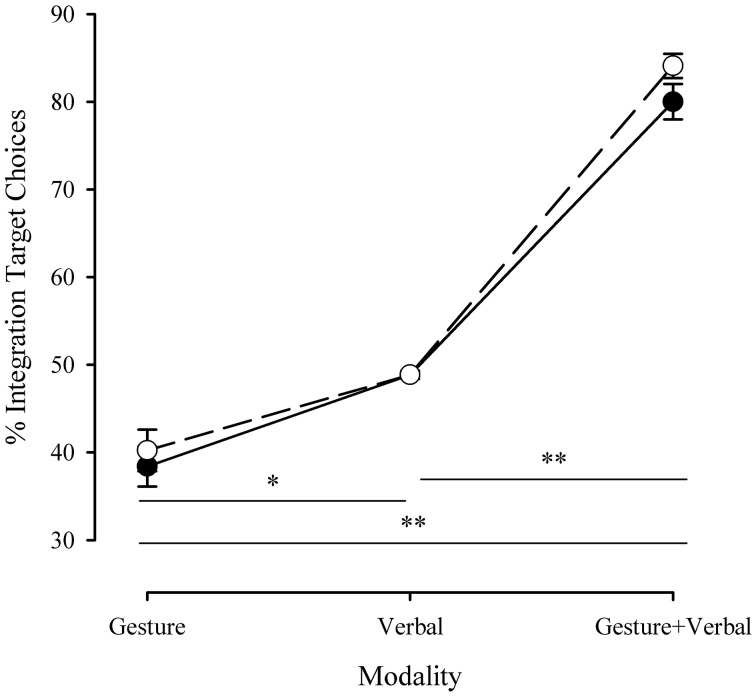
Proportion of integration target image selection for each communication modality, in dependence of the communication performance medium. Shaded symbols: robot communication, empty symbols: human communication. Error bars represent ±1 SEM. *p < 0.0005; **p < 0.0001. © 2015 IEEE. Reprinted, with permission, from Bremner and Leonards (2015a).